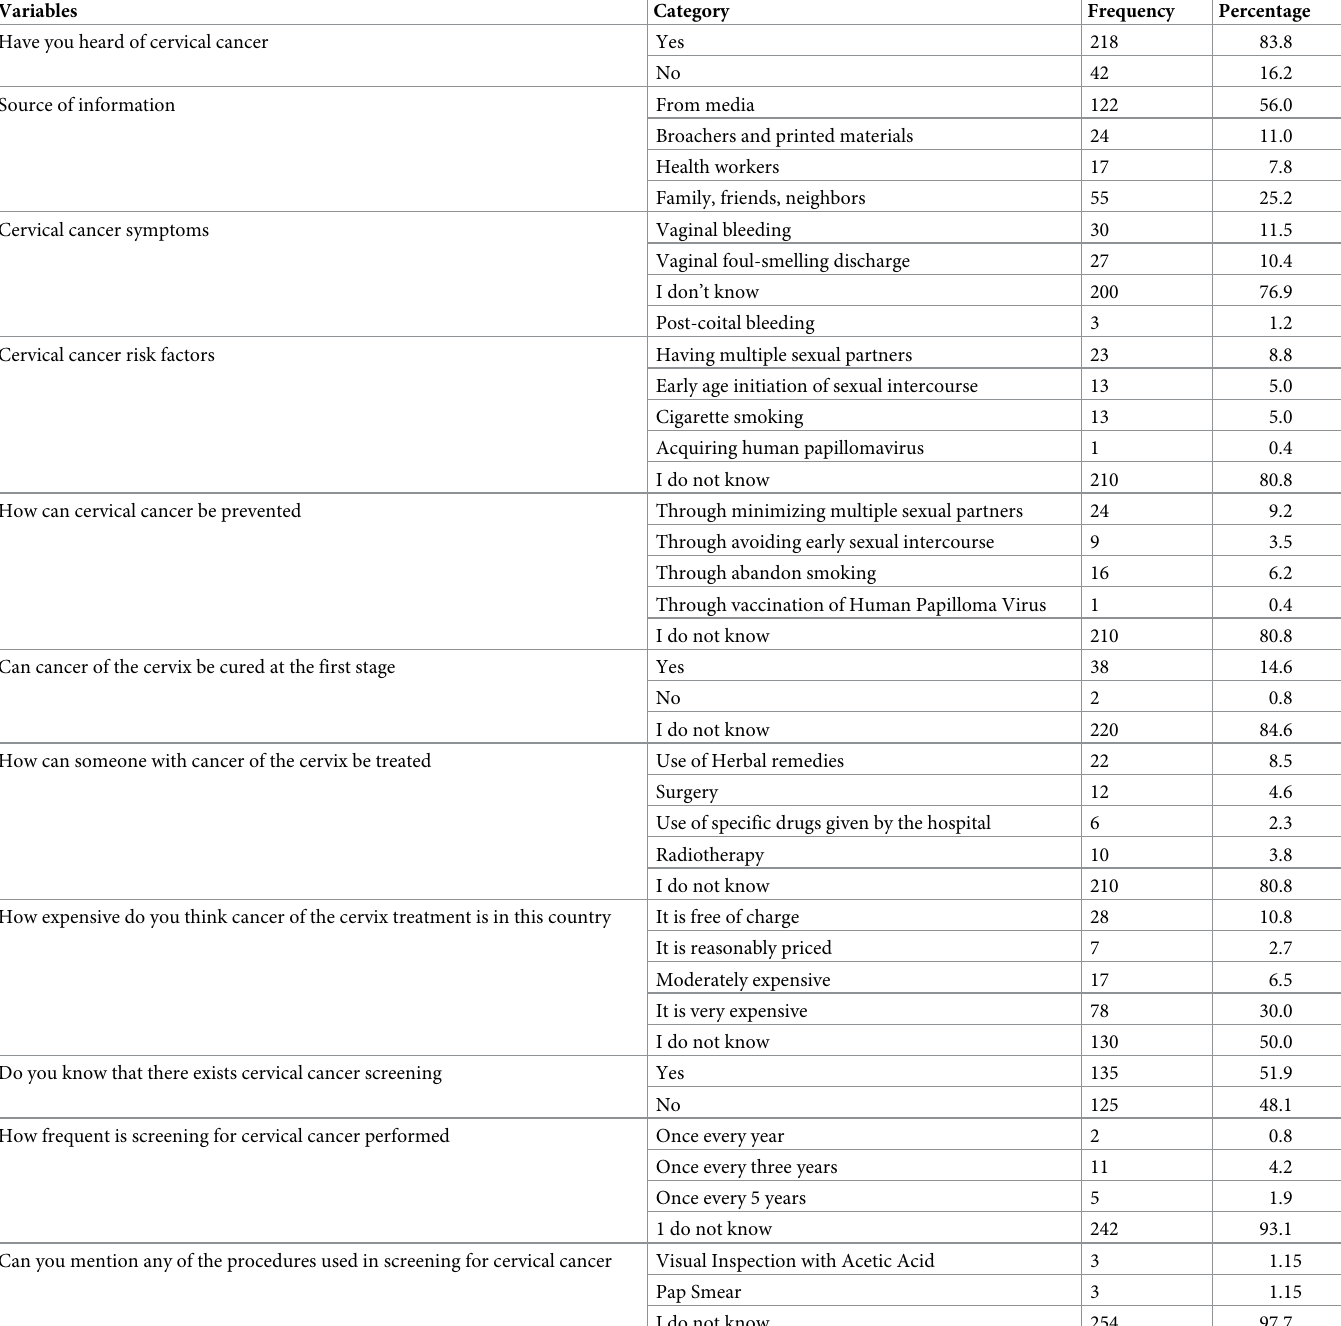
Table 3. Knowledge of cervical cancer screening among reproductive age group women in districts of Gurage zone, Southern Ethiopia,